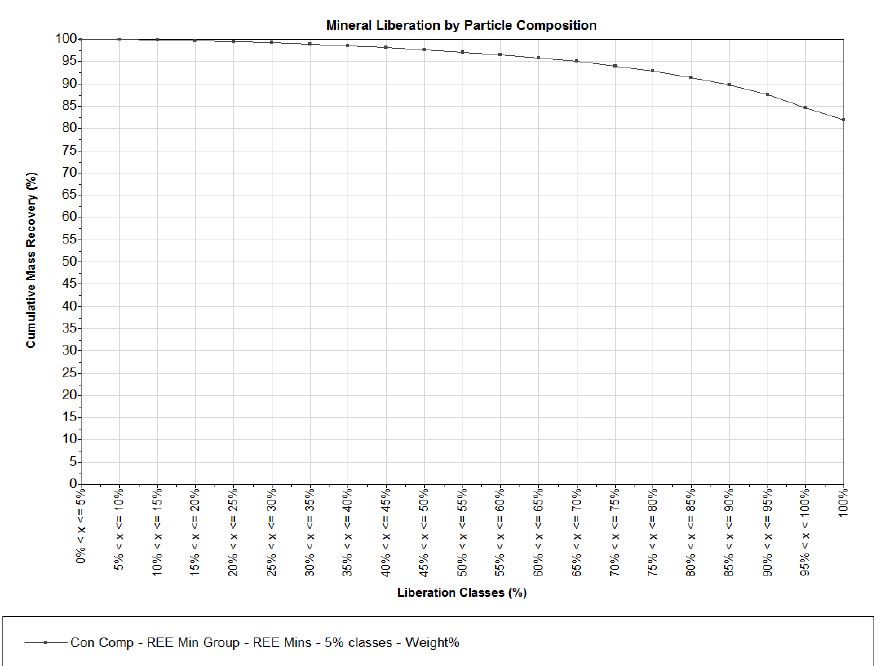
Figure 6. Mineral liberation by individual REE mineral species in MPC material MLA sample.